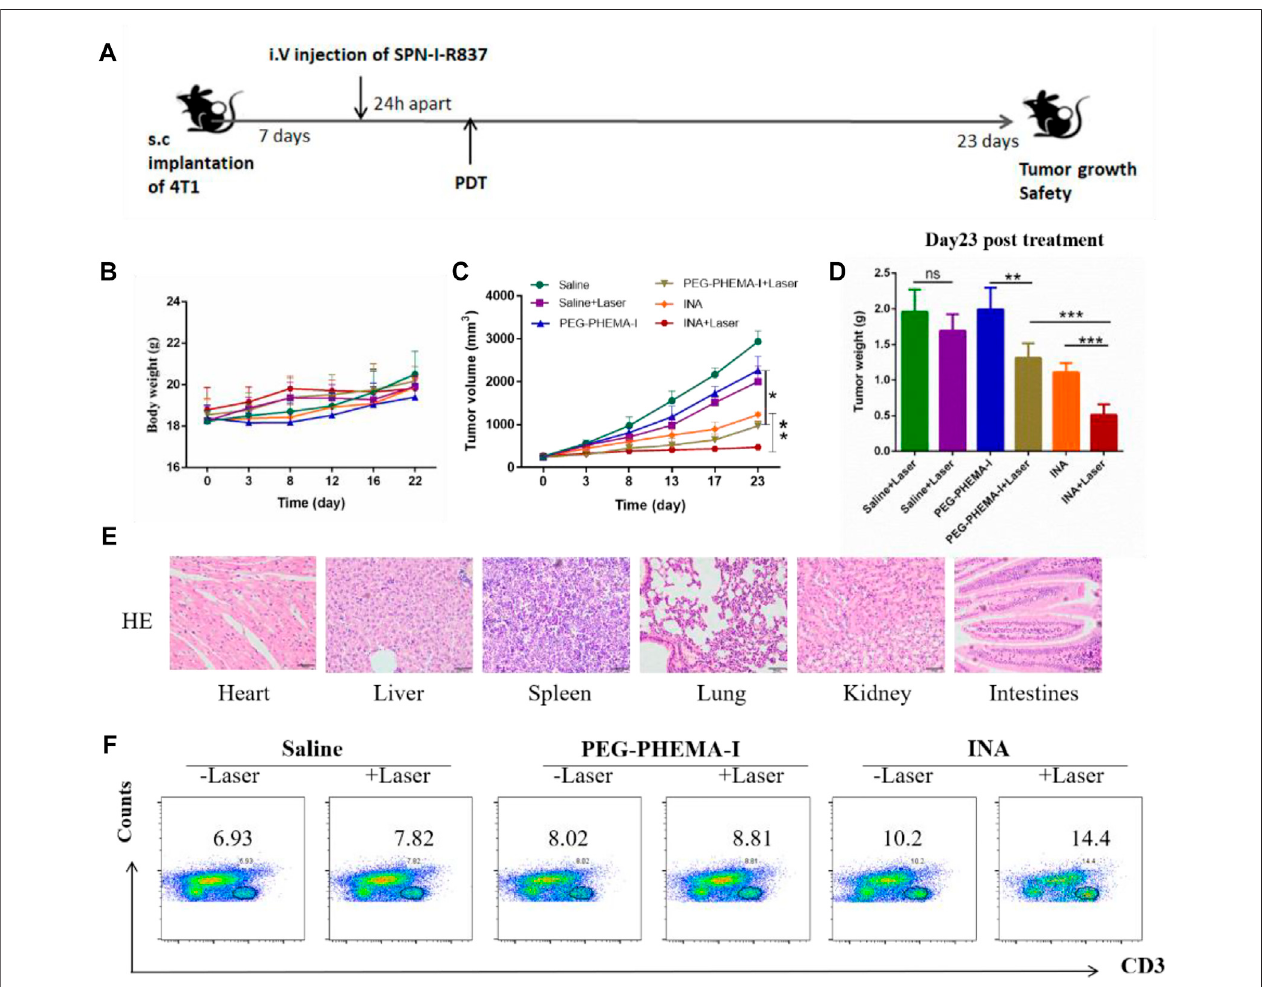
FIGURE6| In vivo antitumor effects. (A) Schematic illustration ofourexperiment design. Mice with 4T1tumors were used inourexperiment. (B) Mice body weight curves of different groups of mice (six mice per group). (C) Tumor growth curves of different groups of mice (six mice per group). (D) Tumor weight of the treated mice 23 d since the start of the therapy. (E) H&E staining of the major organs of INA + laser group of mice. (F) Proportions of tumor-in fi ltrating CD3 + T cells.